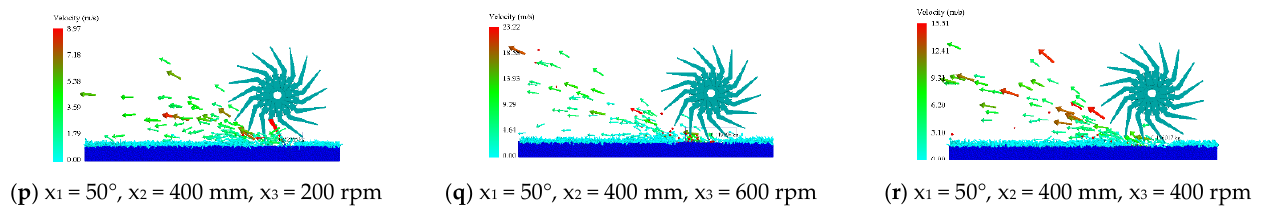
Figure 5. Velocity magnitude and position distribution of the lateral moving and throwing of the straw in discrete element simulation test.